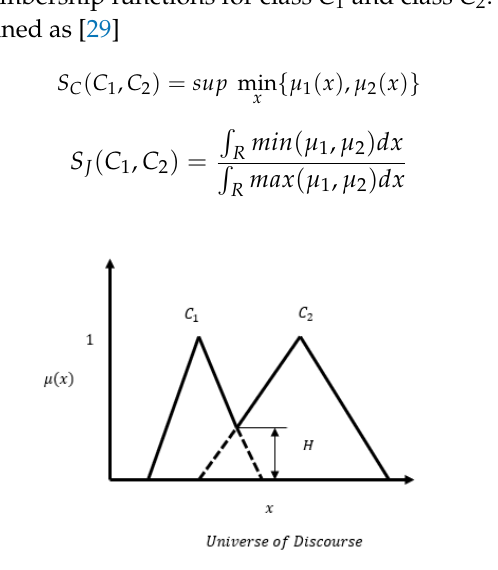
Figure 3. Concordance and Jaccard similarity